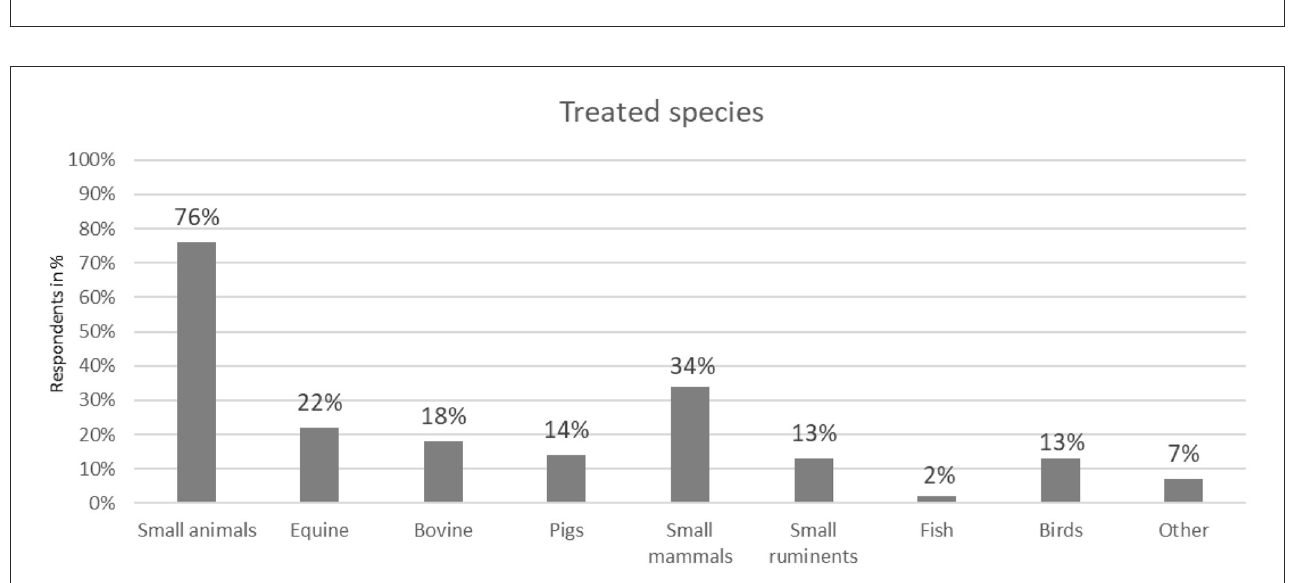
FIGURE2 Animals treated in practices by respondents ( N = 169, multiple answers possible).